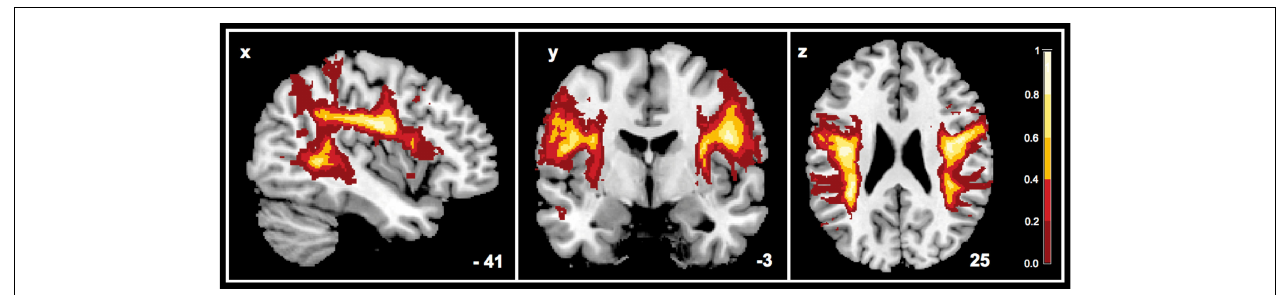
FIGURE 2 | Here the probability map for the SLF of the AP group ( n = 13) is illustrated – combined for two hemispheres. Voxels are displayed with unthresholded